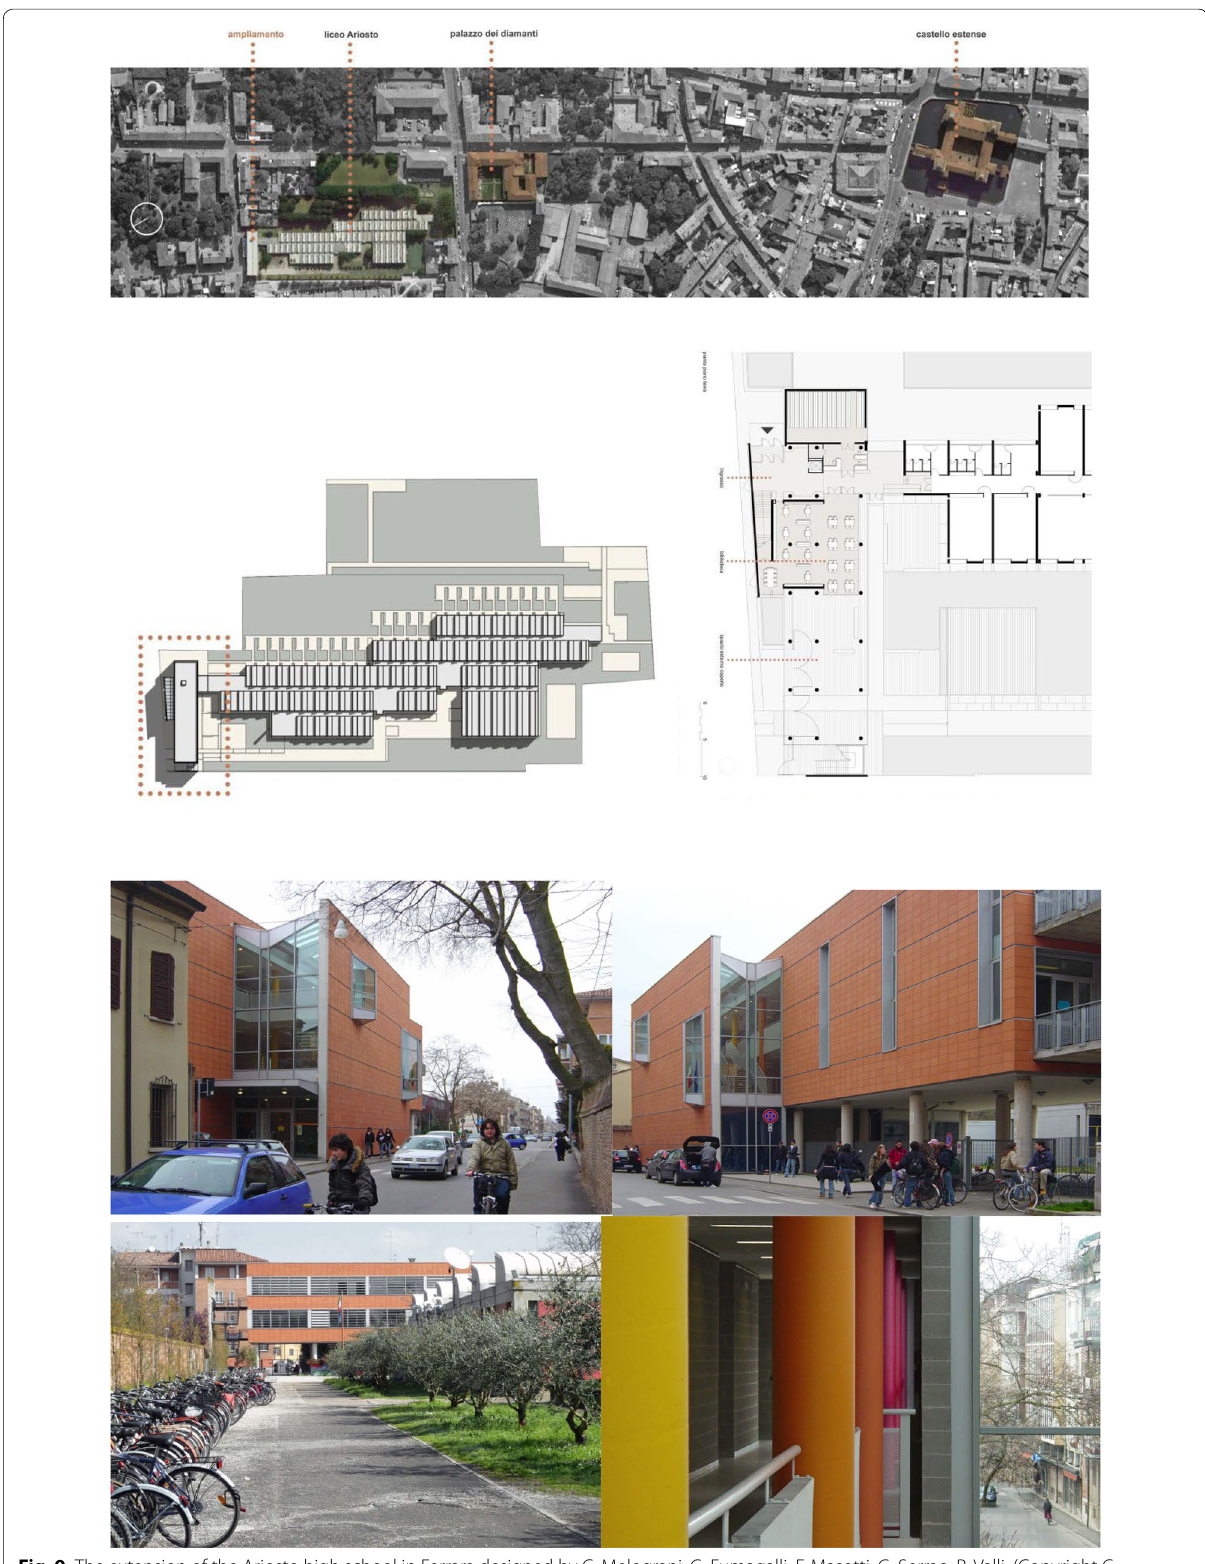
Fig. 9 The extension of the Ariosto high school in Ferrara designed by C. Melograni, G. Fumagalli, F. Masotti, G. Serrao, R. Valli. (Copyright C. Melograni, G. Fumagalli, F. Masotti, G. Serrao, R.